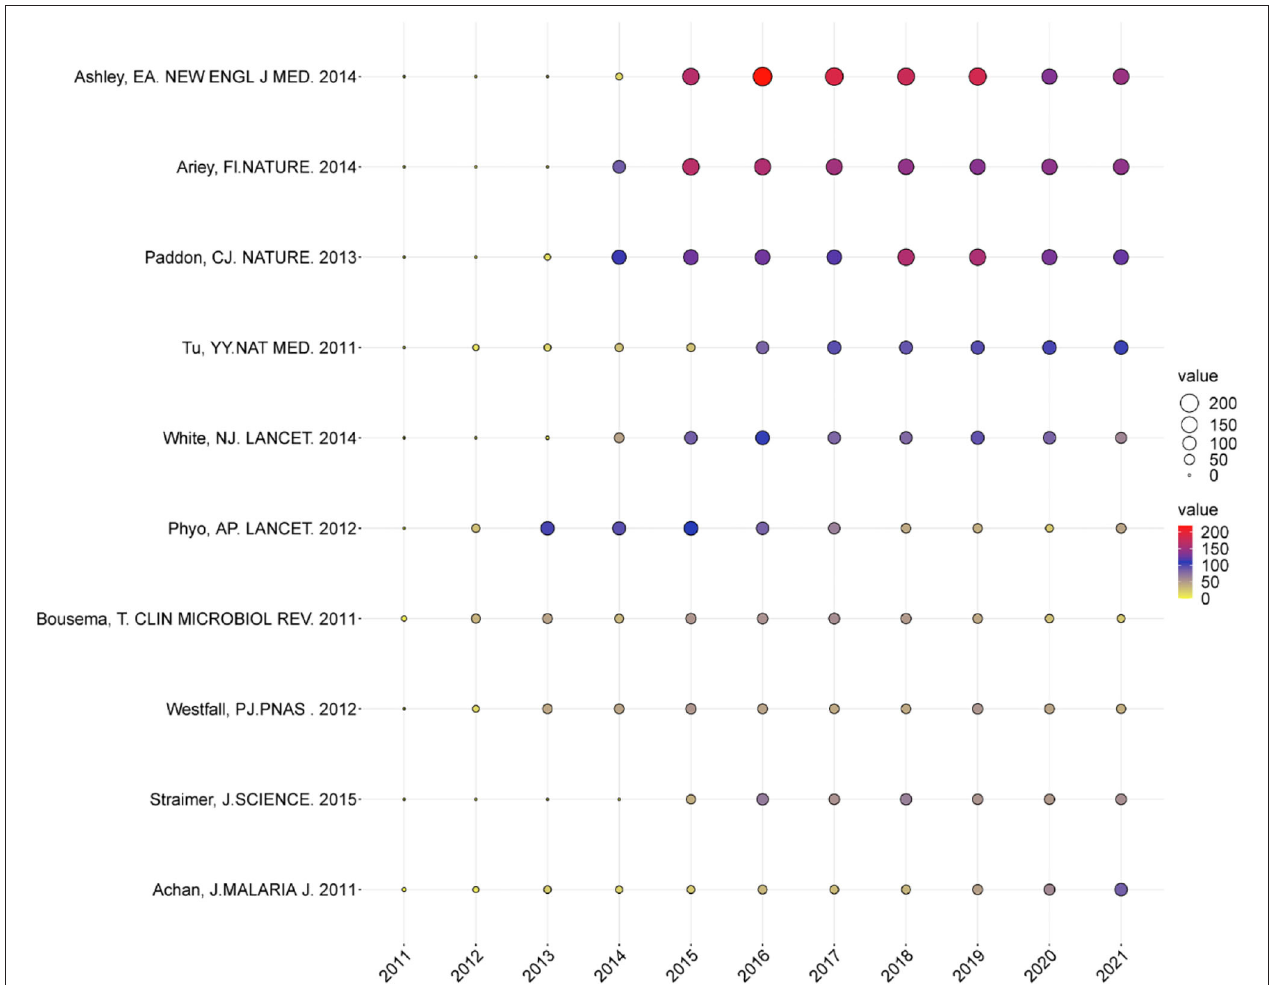
FIGURE 6 | The yearly number of global citations of papers with high global citations (GCS). The size and colors of the circle represent the GCS of